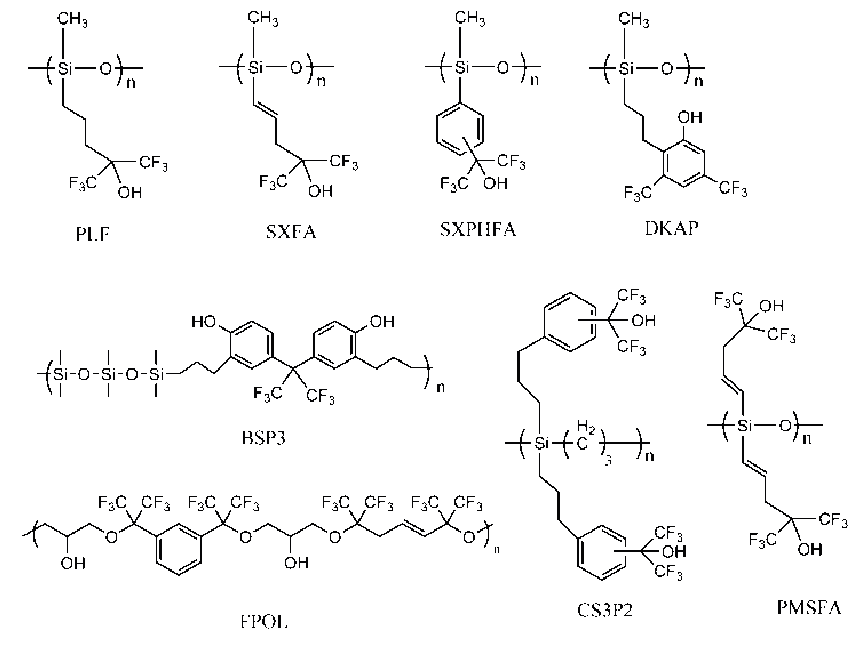
Figure 1. Some typical previously reported HBA